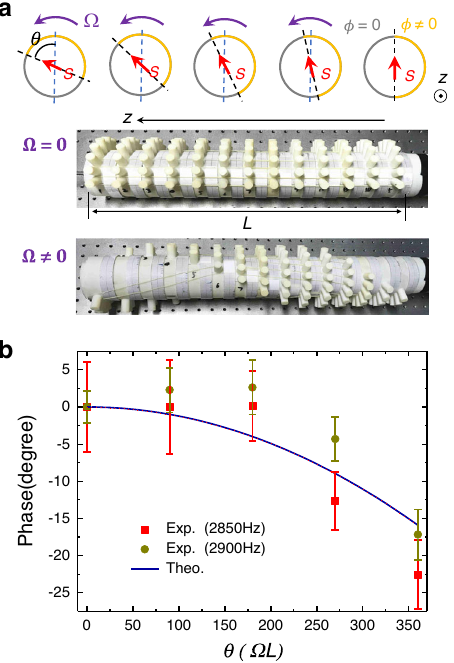
Fig. 6 Rotating metasurface waveguide for rotating acoustic spin as a phase modulator. a Rotating the boundaries of metasurface waveguide with angular velocity Ω will lead to rotating spin texture that resembles the motion of electron spin precession under an effective “ magnetic fi eld ” Ω . The fi nal rotation angle will be θ = Ω L , where L is the length of waveguide. b The experimentally measured acoustic additional phase γ at 2.85 and 2.9 kHz with the standard deviation as the error bar. The theoretical θ 2 , where k = 24. 5°/cm is the prediction can be represented by γ ¼ kR 2 0 2 L measured wave vector for 2.9 kHz, L = 60 cm and R 0 = − 1.4 cm (See Supplementary Note 3).